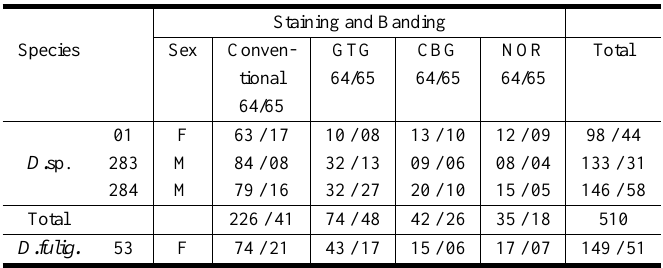
Number of 2n=64 and 2n=65 cells, collected from peripheral blood, bone marrow and spleen, in Dasyprocta sp. and peripheral blood, in D. fuliginosa . Staining and Banding Species Sex Conven- GTG CBG